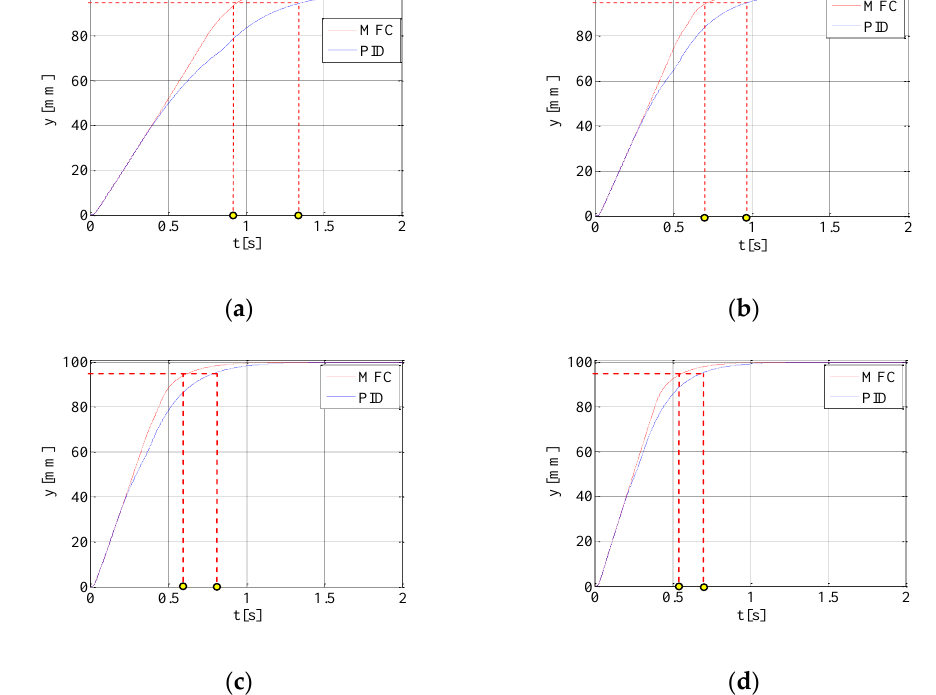
Figure 7. Impact of pressure changes: ( a ) p 0 = 6 MPa, ( b ) p 0 = 8 MPa, ( c ) p 0 = 10 MPa, ( d ) p 0 = 12 MPa; F L = 10,000 N. The impact of individual controller parameters for both loops is shown in Figure 8.